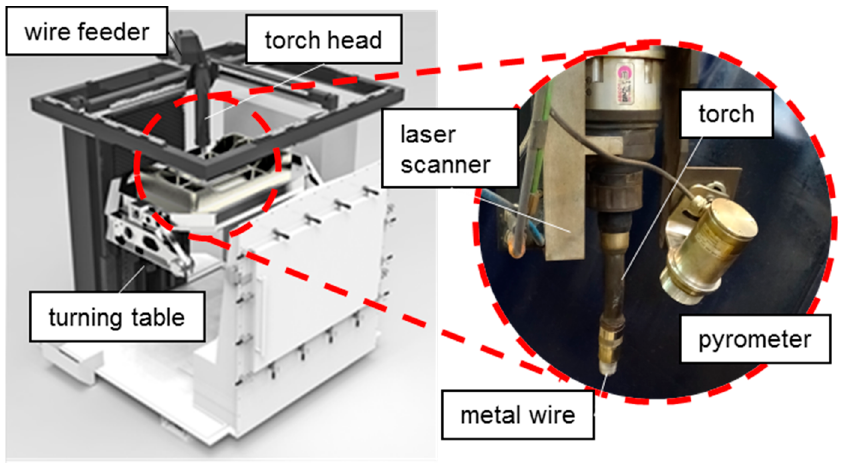
Figure 1. Addilan Additive Manufacturing (AM) machine; the welding torch equipped with a geometrical laser scanner and a pyrometer.